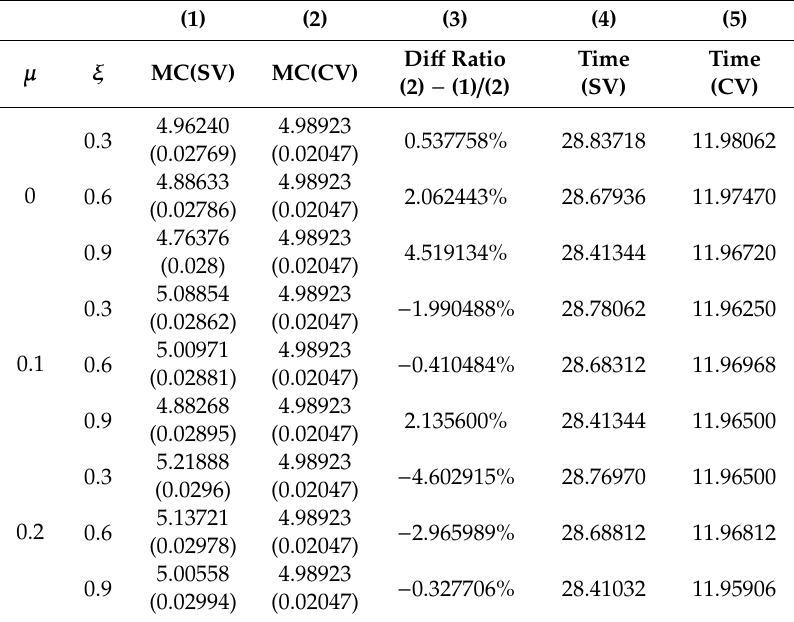
Table 1. Comparison of FSAOs with stochastic and constant